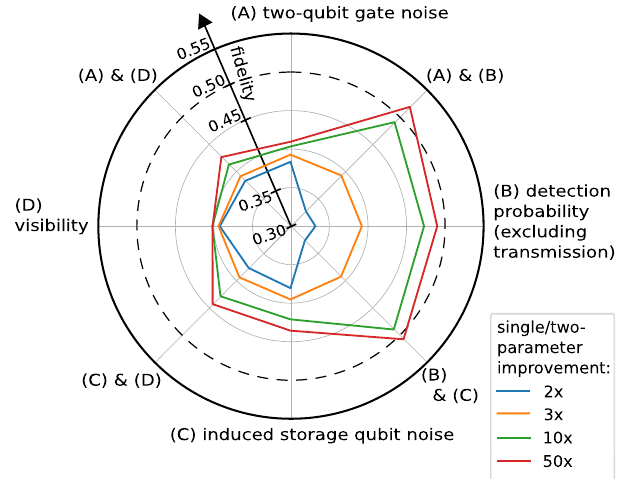
Fig. 6 Sensitivity of fi delity in various hardware parameters for nitrogen- vacancy (NV) repeater chains. The NV hardware model consists of ~15 parameters and from those we focus on four parameters in this fi gure: (A) two-qubit gate fi delity, (B) detection probability, (C) induced storage qubit noise and (D) visibility. We start by improving all ~15 parameters, including the four designated ones, using an improvement factor of 3 (Methods, section ‘ How we choose improved hardware parameters ’ ). Then, for each of the four parameters only, we individually decrease their improvement factor to 2, or increase it to 10 or 50. The fi gure shows the resulting fi delity (horizontal and vertical grid lines; dashed line indicates maximal fi delity which can be attained classically). Note that at an improvement factor of 3 (orange line), all ~15 parameters are improved by three times, resulting in a fi delity of 0.39. In addition, we vary the improvement factor for combinations of two of the four parameters (diagonal lines). The 3 × improved parameter values can be found in Supplementary Table II. The other values (at 2/10/50×) are approximately: two-qubit gate fi delity F EC (0.985/0.997/0.9994), detection probability p nofibre (6.8%/58%/90%), det induced storage qubit noise N 1/ e (2800/14,000/70,000), visibility V (95%/99%/99.8%). The fi delities shown are obtained by simulation of the SWAP-ASAP protocol (three repeaters) with a total spanned distance of 500 km. Each data point represents the average of 1000 runs (standard deviation on fi delity <